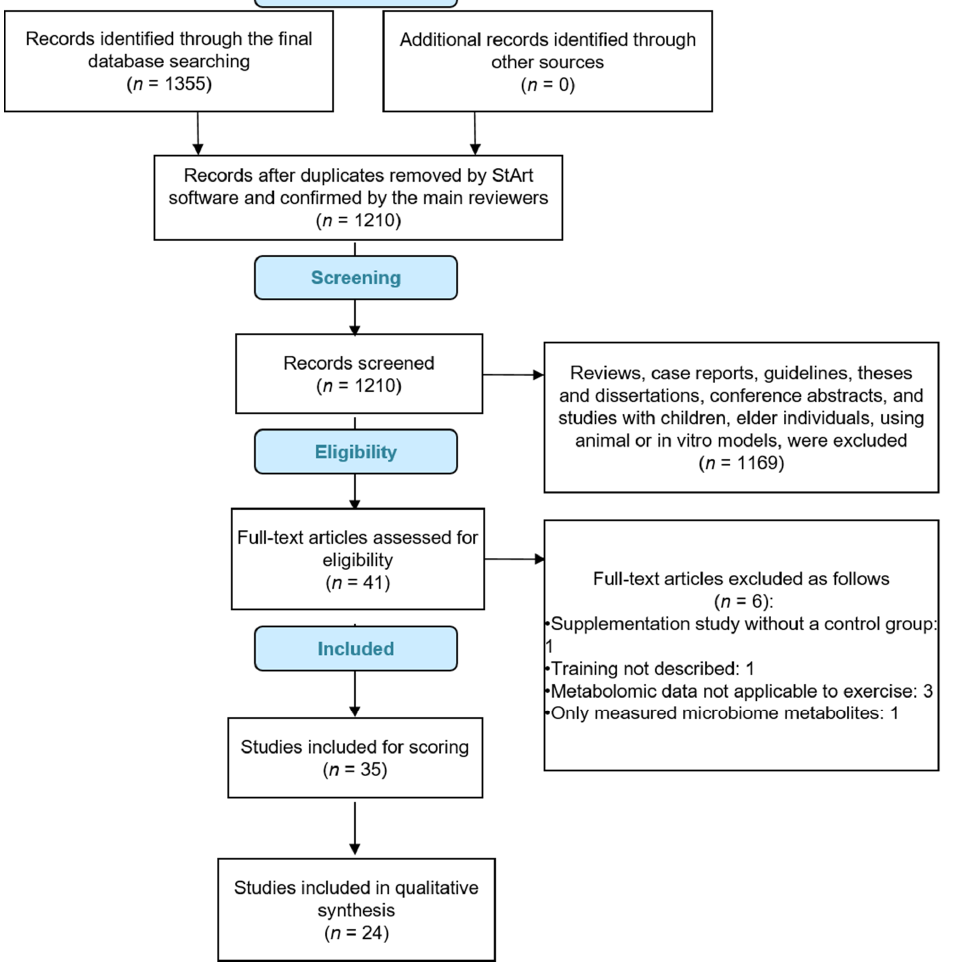
Figure 1. Outcomes of review flow diagram.